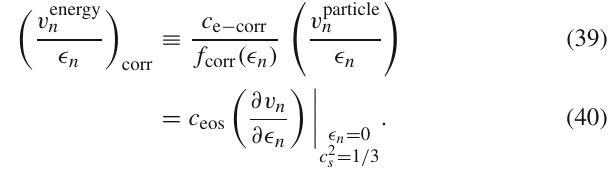
bands for η/ s = 1 / 4 π ( η/ s = 2 / 4 π , η/ s = 3 / 4 π ) in Fig.